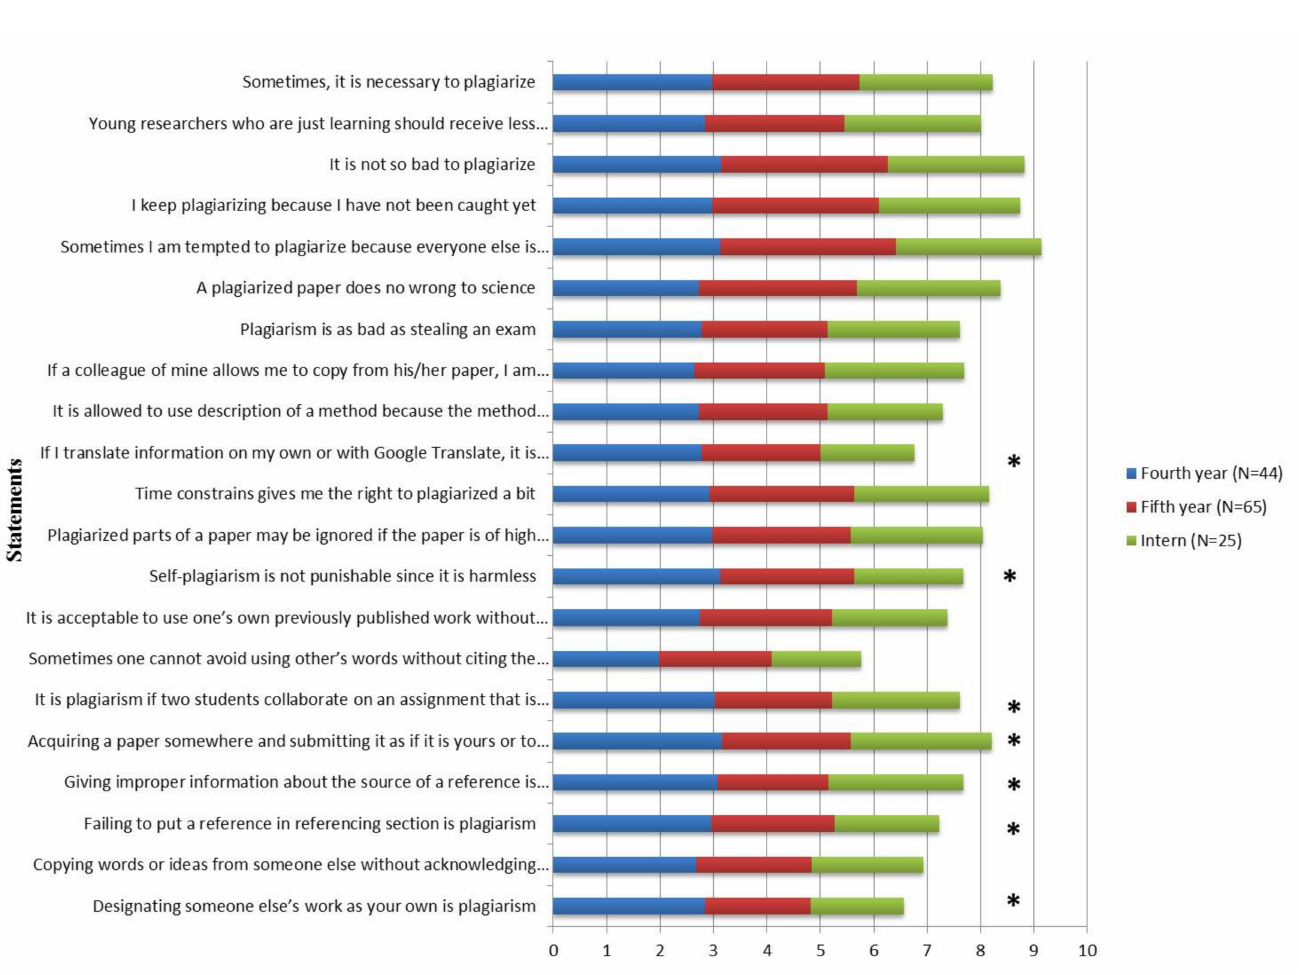
Figure 1. Students’ responses on plagiarism by academic years (expressed in mean). * Statistically